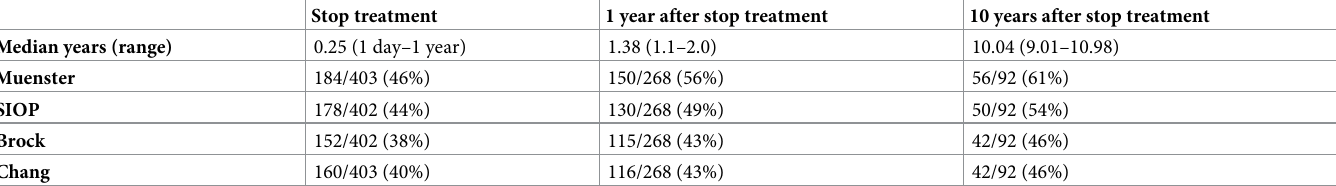
Table 4. The prevalence of deleterious hearing loss at stop treatment, 1 year after stop and 10 years after stop treatment.